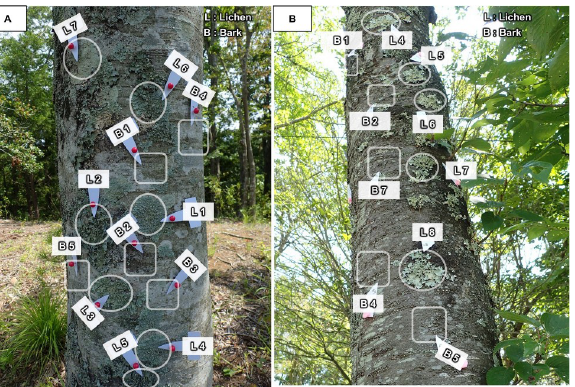
Fig 2. Sampling points of lichens and barks. (A) On a tree trunk of Zelkova serrata . (B) On a tree trunk of Cerasus sp.